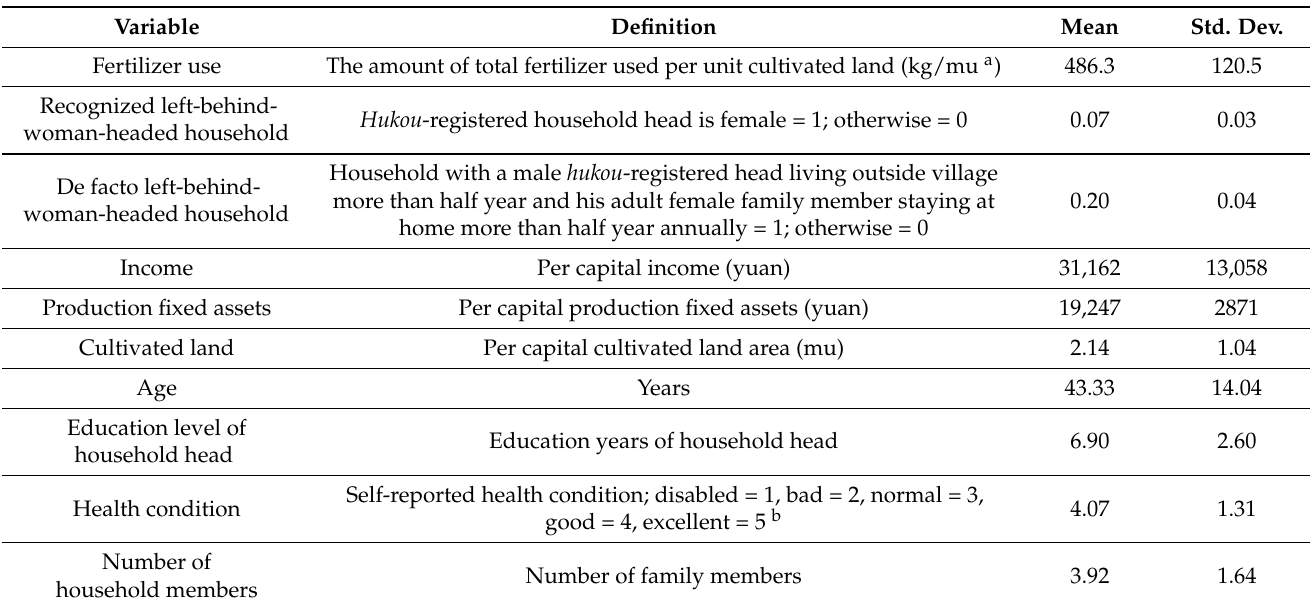
Table A1. Variables and